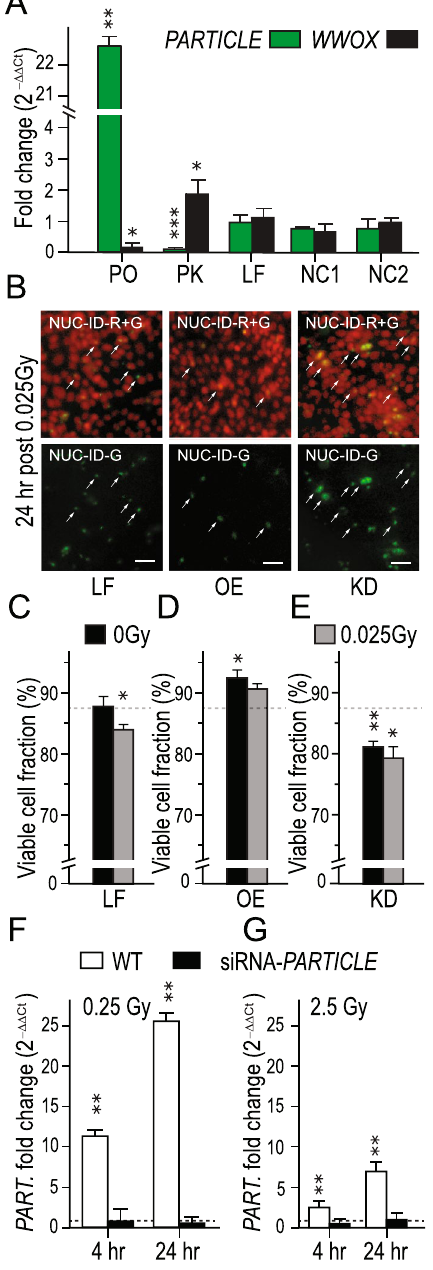
Figure 3. PARTICLE influences WWOX transcript levels. ( A ) Expression of PARTICLE ( green ) or WWOX ( black ) in U2OS control cells (transfected with lipofectamine only (LF), in vitro control transcript (NC1) or negative siRNA control (NC2)), PARTICLE over-expression (PO) or PARTICLE knockdown (PK). Values were normalized with the TATA-binding protein (TBP) encoding endogenous gene with relative expression comparison to relevant control. PARTICLE over-expression enhances cancer cell line viability. ( B ) Representative epifluorescence micrographs of MDA-MB-361 lipofectamine treated (LF), PARTICLE over- expressing (OE) or knockdown (KD) 24 hr post 0.025 Gy identifying viable (red) or non-viable cells (green; lower) using NUCLEAR: ID (NUC-ID; Enzo). Merged images of red and green (R + G) stained nuclei (upper). Scale bar 25 μ m. ( C – E ) Summary plots illustrating percentage viable cell fraction in LF, OE and KD 24 hr post sham irradiated or 0.025 Gy. Data are represented as mean ± SEM (n = 3) with significance represented by asterisks (p < 0.05) where appropriate. PARTICLE response to irradiation exposure is removed after siRNA interference. ( F , G ) Expression of PARTICLE 4 and 24 hr following 0.25 ( F ) or 2.5 Gy ( G ) irradiation in MDA-MB-361 (negative siRNA (NC2) control transfected (WT: white bars)) or PARTICLE siRNA transfected MDA-MB-361 (siRNA- PART .: black bars)). Values were normalized with the TBP encoding endogenous gene with relative expression comparison to sham-irradiated (0 Gy) cells (dashed